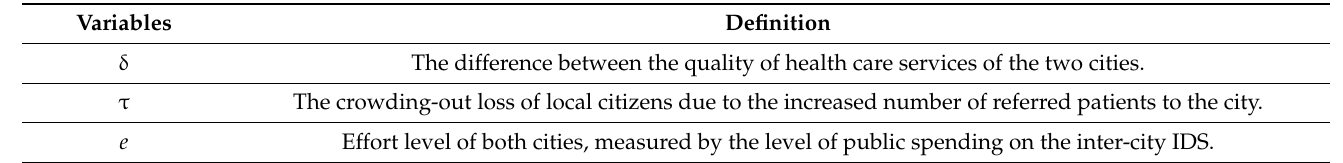
Table 1. Key variables in the economic model at the inter-local government